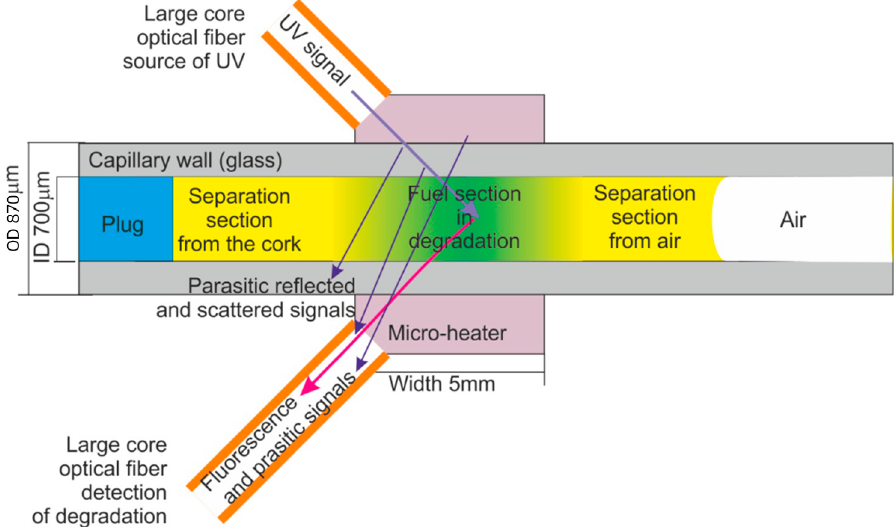
Figure 5. The idea of diesel fuel local section exclusive degradation with UV radiation and reading of degradation results. degradation